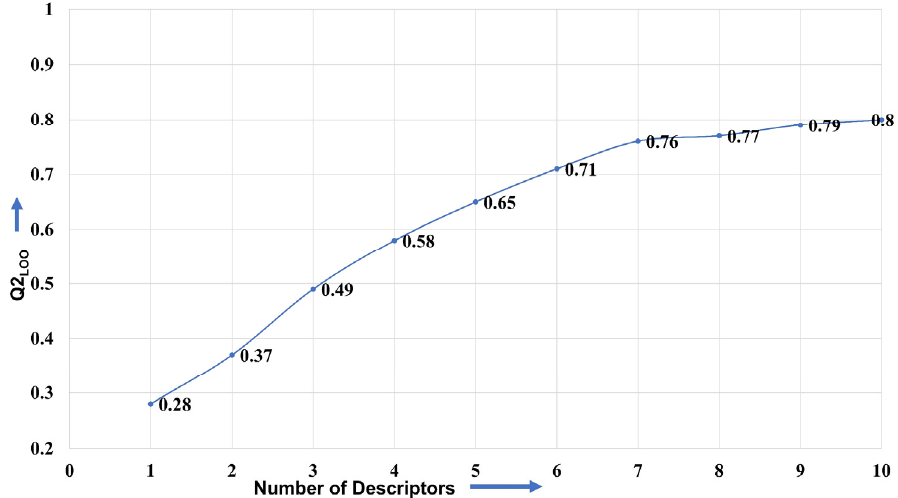
Figure 9. Graph between number of descriptors against leave-one-out coefficient of determination Q 2LOO to identify the optimum number of descriptors. Q 2 LOO to identify the optimum number of